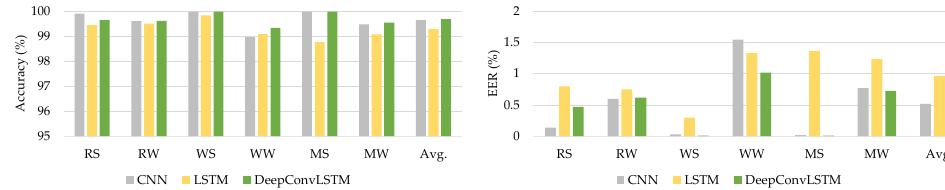
Figure 8. The comparative results using the HMOG